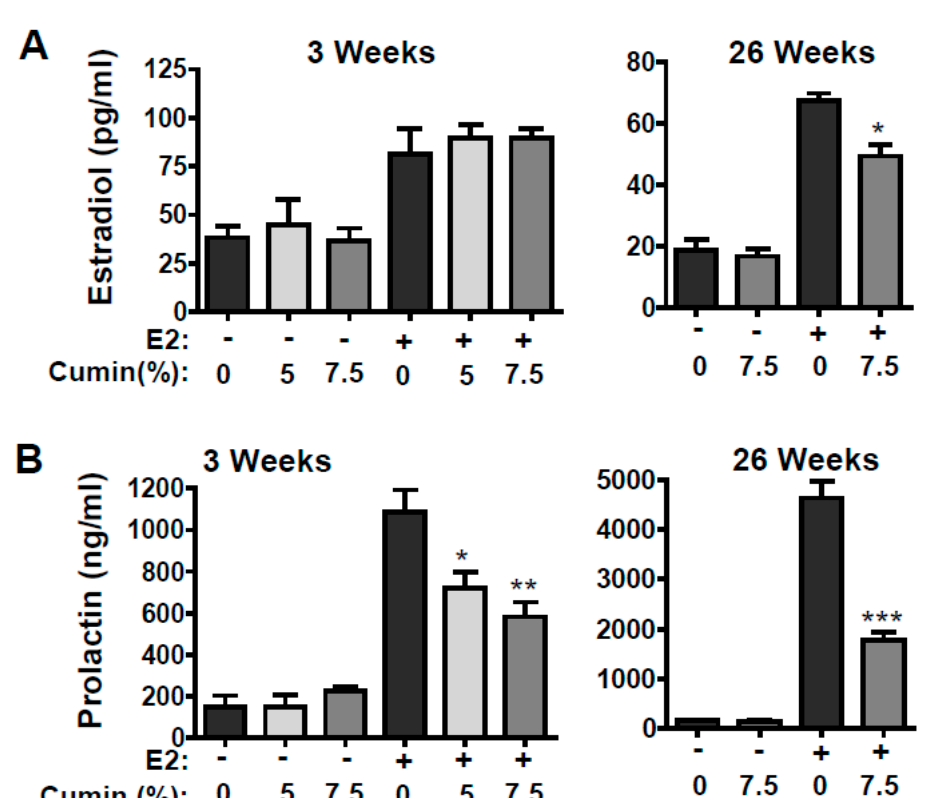
Figure 4. Effect of cumin powder diet on circulating 17ß-estradiol (E2) and prolactin. Time- (3 and 26 weeks, 7.5%, w / w ) and dose-dependent (5% vs. 7.5%, w / w at 3 weeks) effect of cumin diet on circulating E2 levels ( A ) or prolactin levels ( B ) was measured in the blood plasma of the animals and compared with control animals. Data represent mean ± SD (n = 6). * p < 0.05, ** p < 0.01, *** p < 0.001.